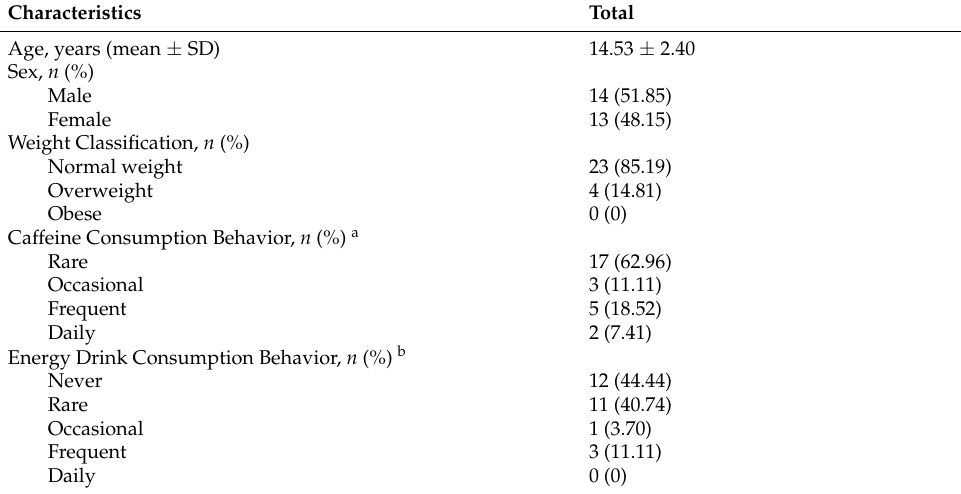
Table 1. Study Participants’ Characteristics ( n =